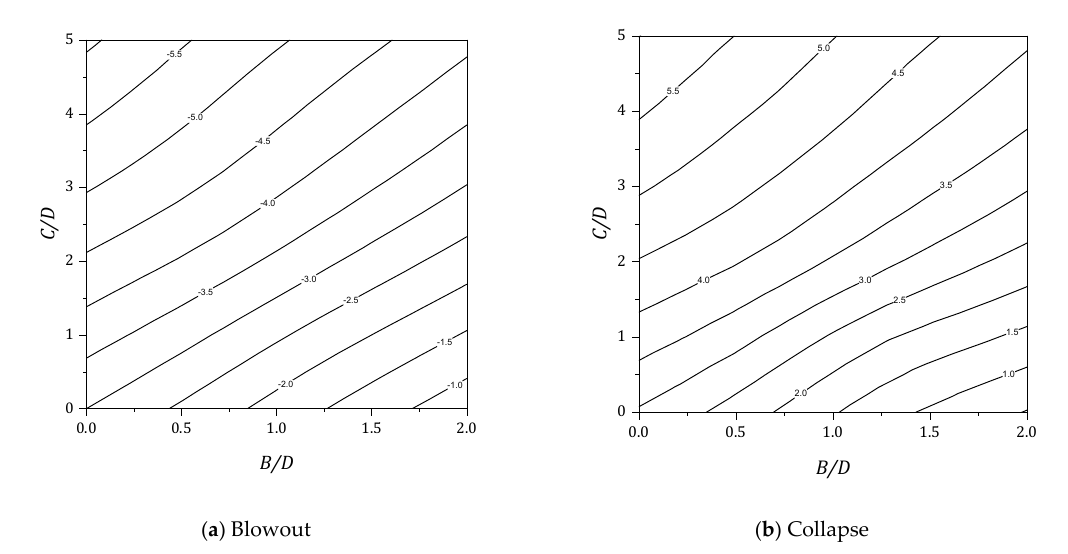
Figure 12. ( σ s − σ t )/S u vs ( C/D ) for various ( γ D/S u ) − B/D = 2.